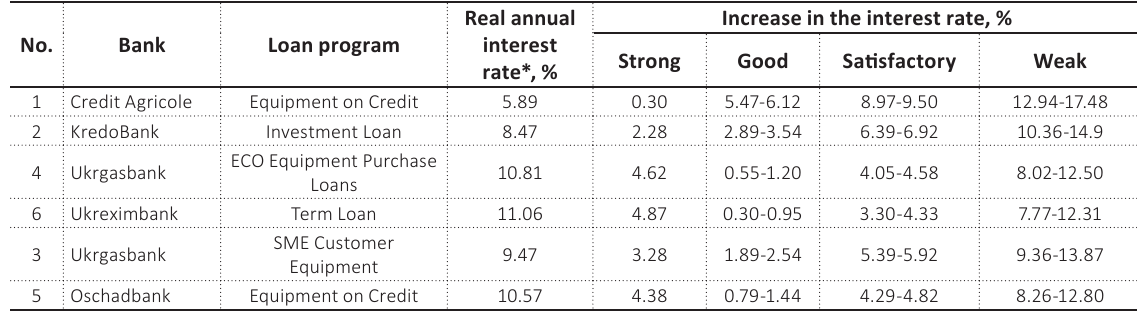
Source: Developed by the authors.